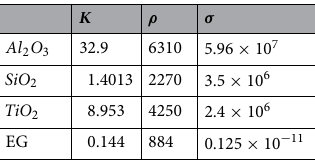
Table 1. Nanoaprticles properties in term of thermal in EG 13